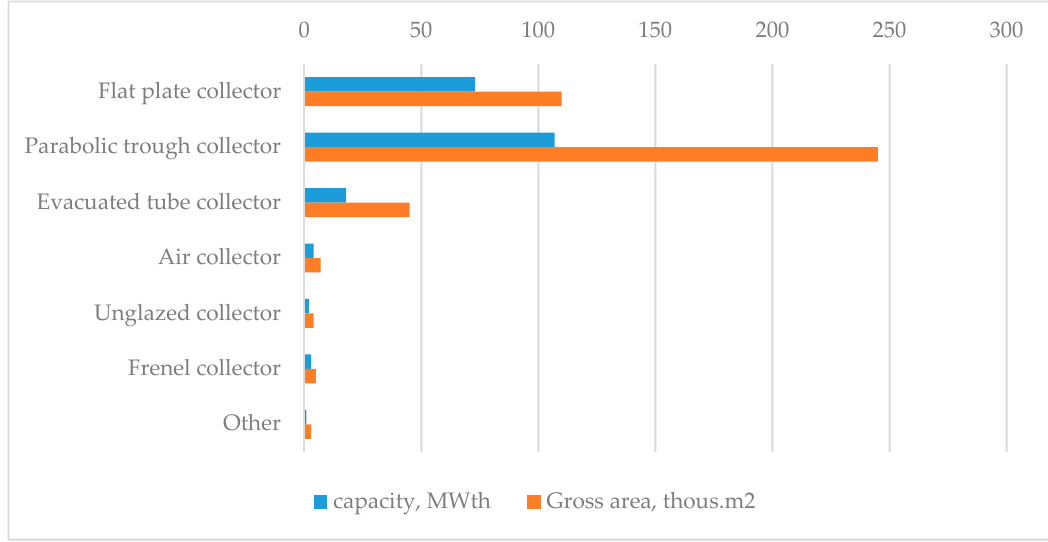
Figure 7. Cumulative area and cumulative power of installed solar collectors in the leading countries [23].